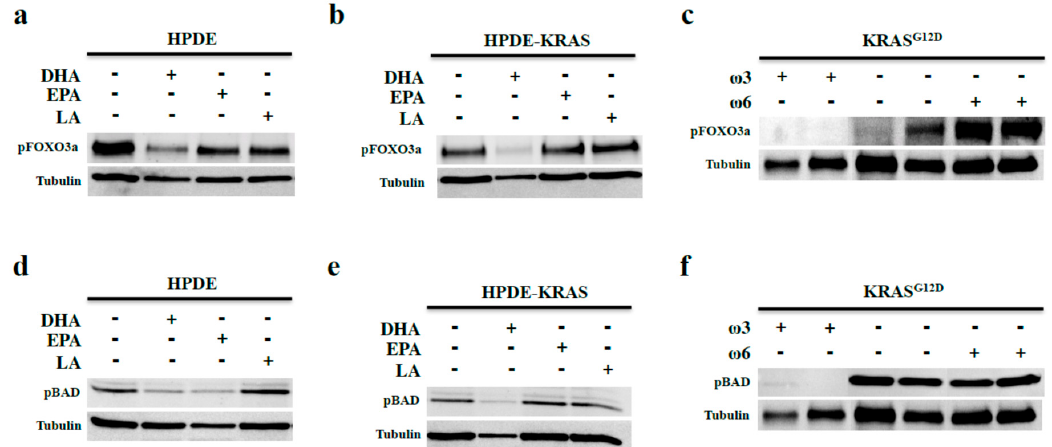
Figure 5 . ω 3 fatty acids prevent FOX3a and BAD phosphorylation in vitro and in vivo. ( a , b ) HPDE and HPDE-KRAS cells were incubated with fixed doses of 40 µM of the ω 3 fatty acids DHA and EPA, or the ω 6 fatty acid LA. Expression of the AKT-target pFOXO3a was assessed by Western blotting. ( c ) pFOXO3a expression was next evaluated in the KRAS G12D mice given control, ω 3-, or ω 6-enriched diets for 11 months. ( d – f ) HPDE and HPDE-KRAS cells incubated with DHA, EPA, or LA and similarly evaluated for expression of the AKT-target pBAD. Additionally, pBAD expression was measured in KRAS mice fed control, ω 3, or ω 6 diets (for 11 months).